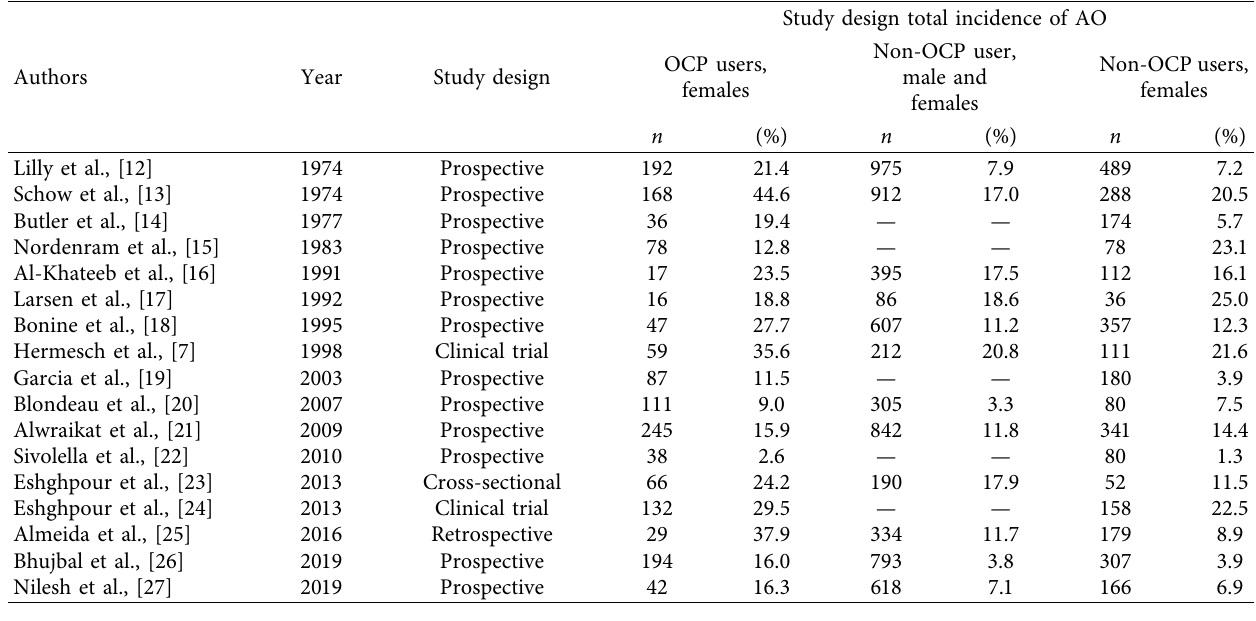
Table 2: Characteristics of the selected studies in this systematic review.